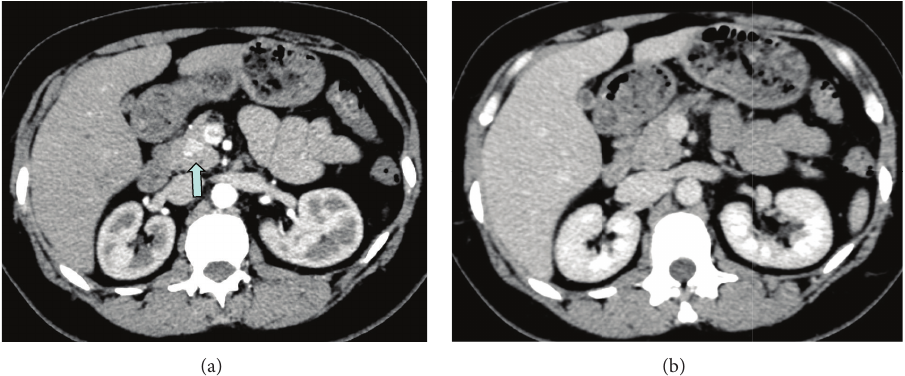
Figure 2: (a) Arterial phase scan through the abdomen demonstrates an enhancing lesion in the pancreatic head (arrow). (b) Venous phase: the lesion has become isoattenuating. Appearances are in keeping with a neuroendocrine tumour.